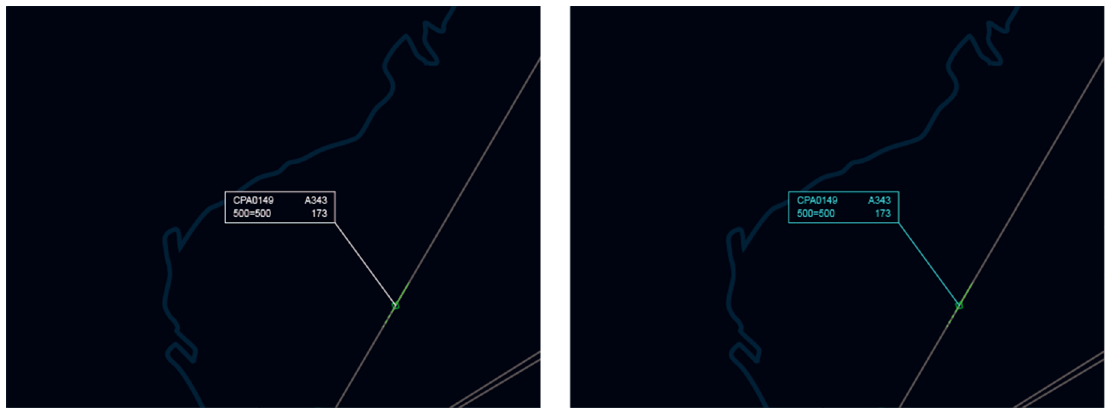
Figure 19. Visual interaction in prompt mode in the central display area.